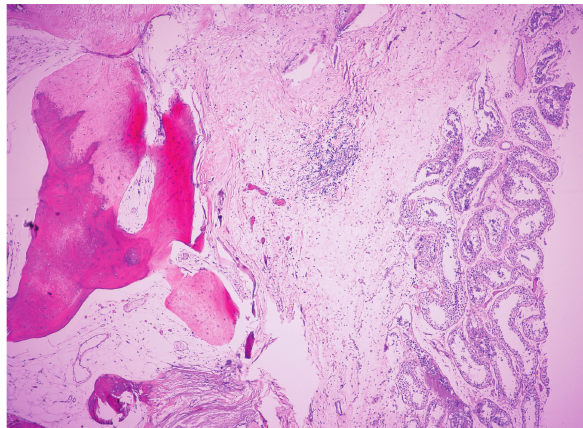
Figure 2 - Histopathological documentation of testicular